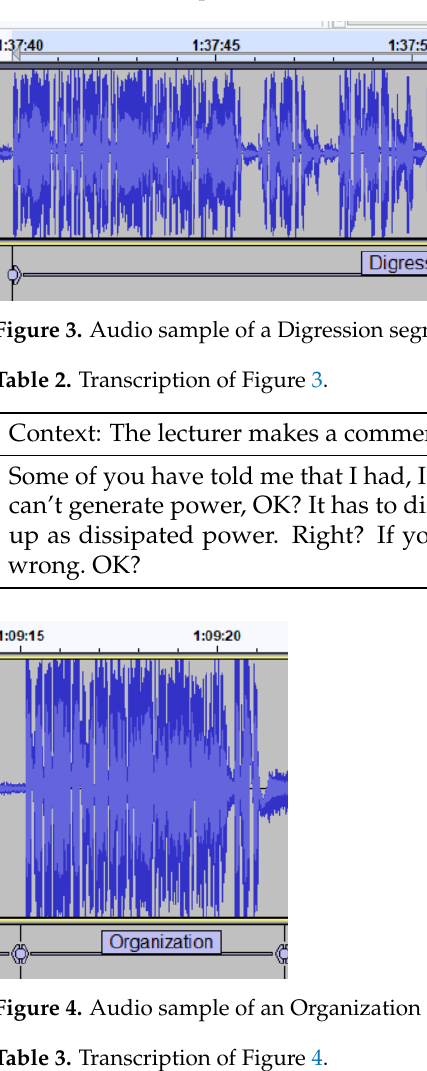
Figure 2. Audio sample of a Miscellaneous segment followed by Indistinct Chat.